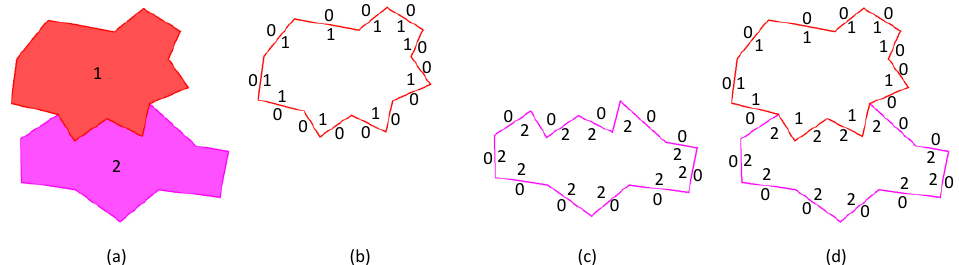
Figure 4. An example of a multi-labeled mesh combined by general meshes without labels: ( a ) two simple input meshes; ( b ) labels of mesh 1; ( c ) labels of mesh 2; ( d ) labels of the multi-labeled mesh. Algorithm 1: Generate multi-labeled mesh